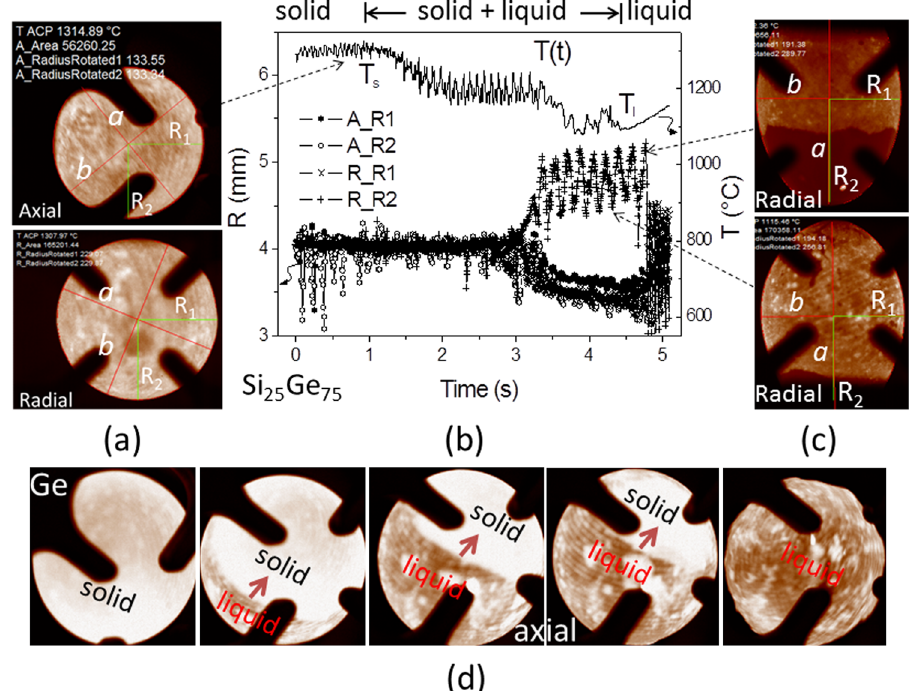
Fig. 1 a Axial and radial images of Si 25 Ge 75 near the solidus temperature T s . b Pro fi les of temperatures and radii measured upon heating. c Radial images of the ellipsoidally deformed molten sample near the liquidus temperature T l . d Axial images of doped Ge during melting with bright and dark domains due to solid and liquid phases, the arrow indicates the rotation direction